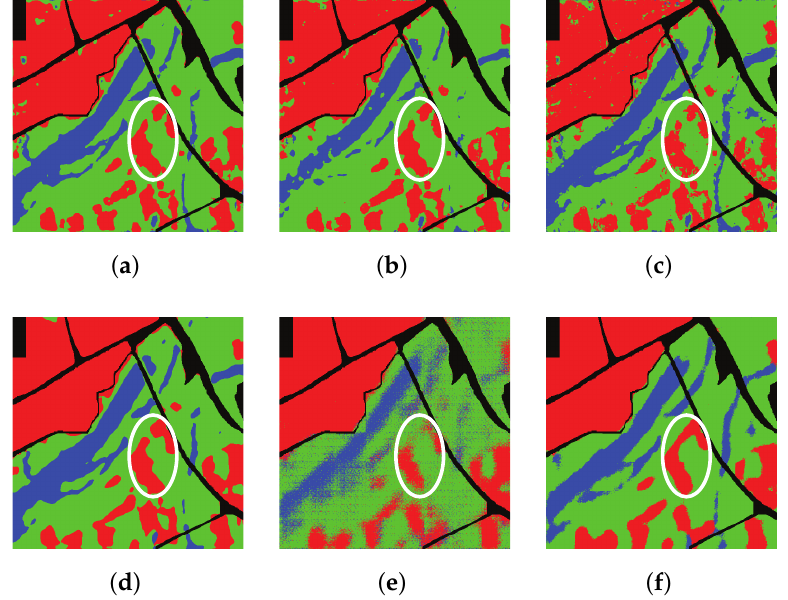
Figure 7. Classification results of Xi’an with various methods. ( a ) SVM. ( b ) SRC. ( c ) SAE. ( d ) CNN. ( e ) SFCN. ( f )